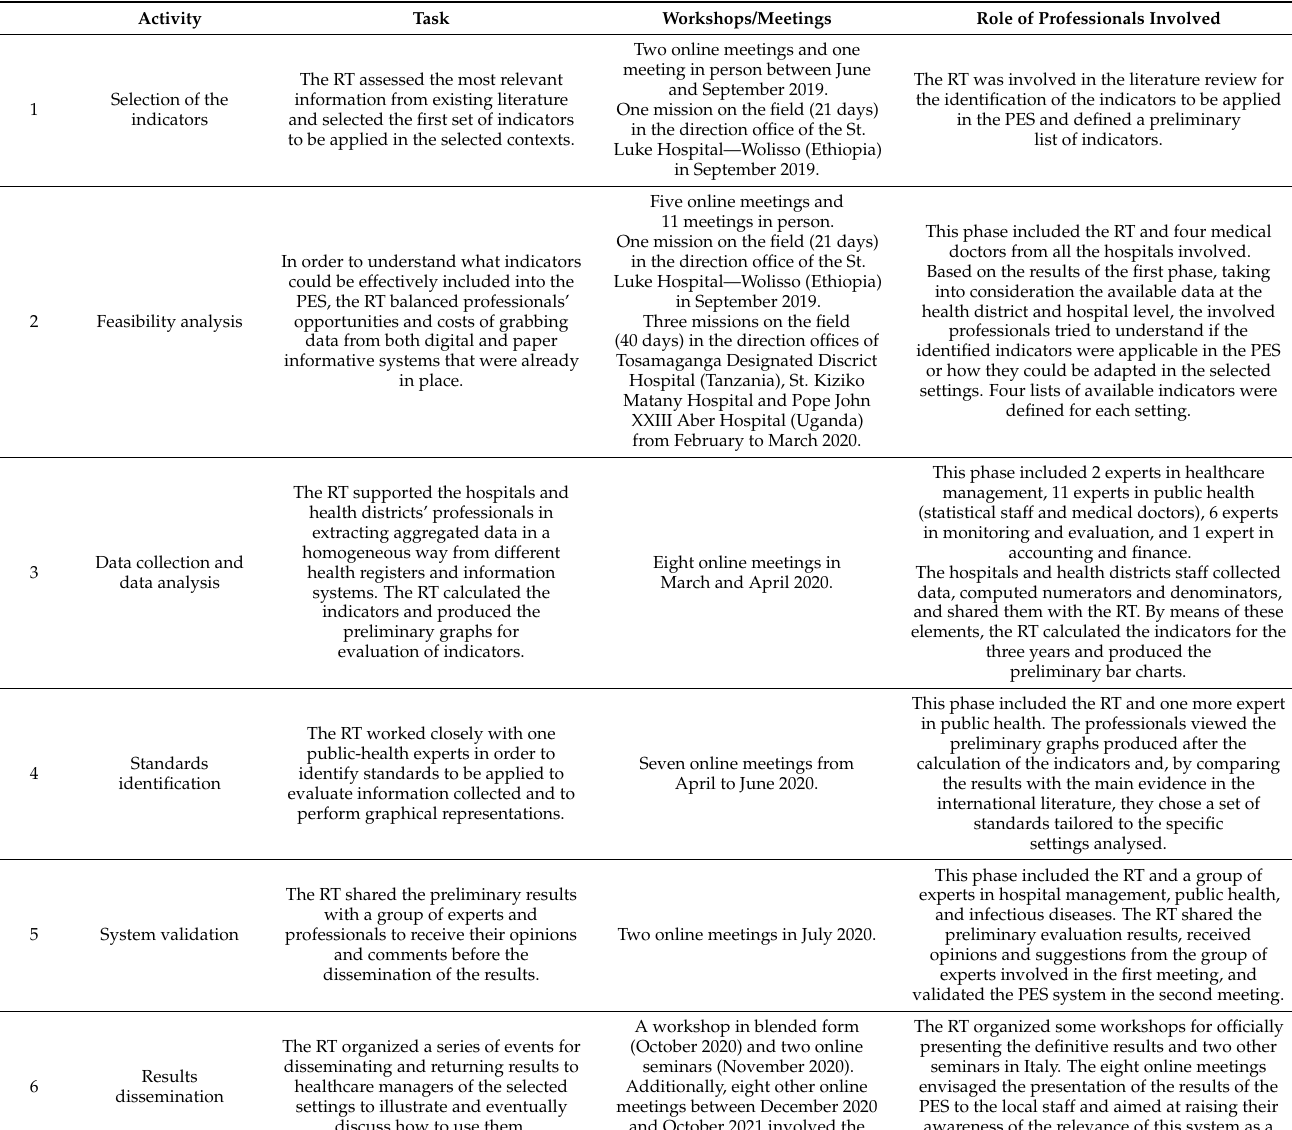
Table 2. The phases that characterized the development of the